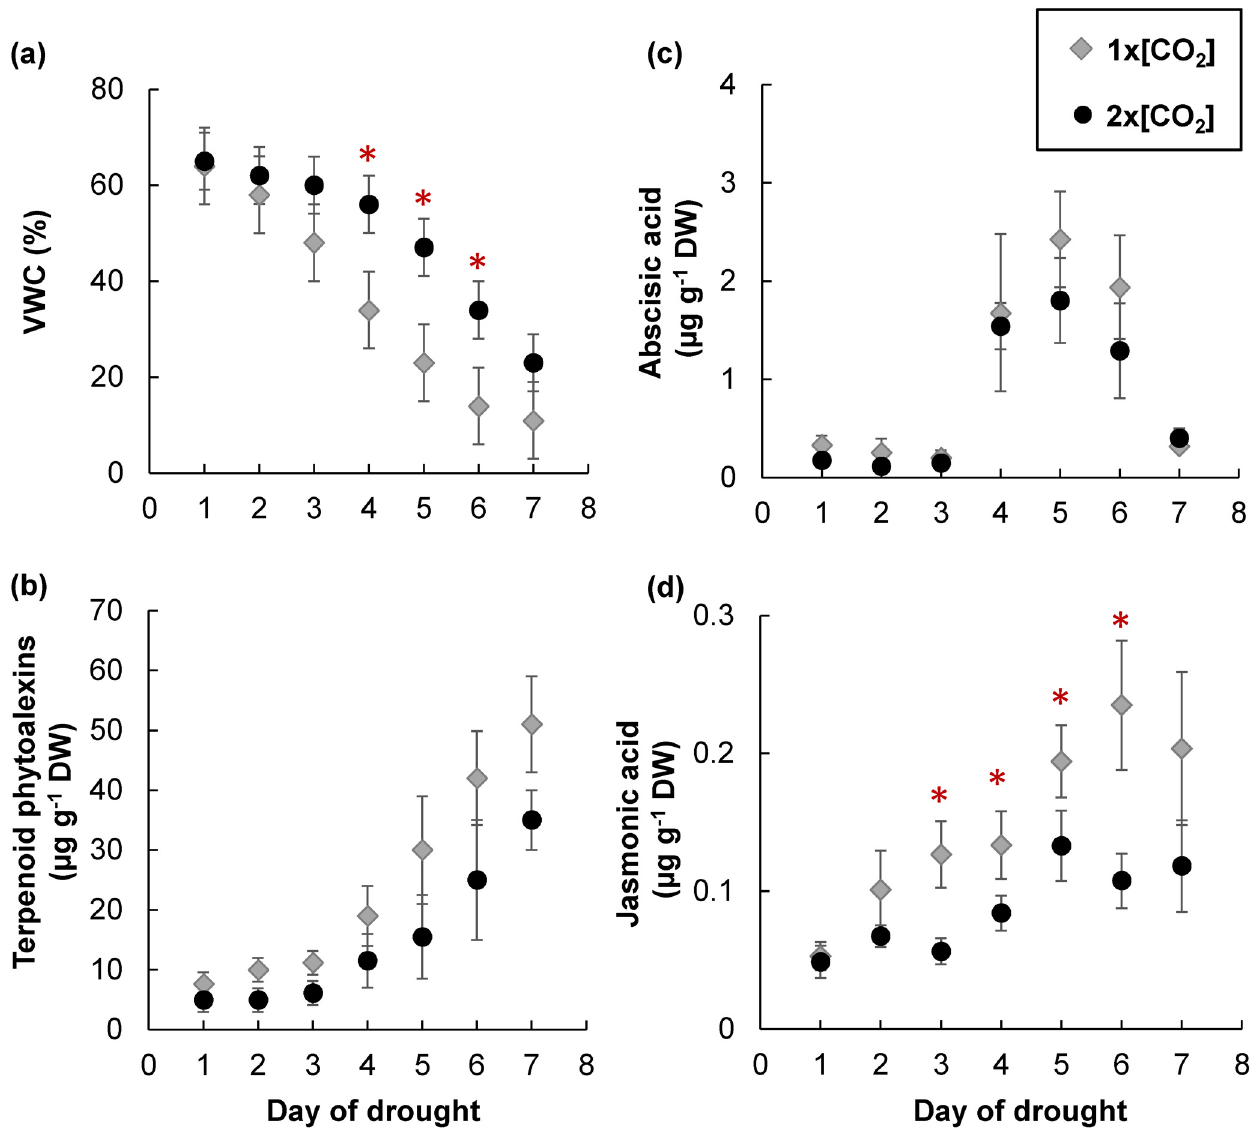
Fig 9. Elevated [CO 2 ] does not inhibit the drought induced accumulation of maize root terpenoid phytoalexins. Water was withheld from V8 stage plants at 1x[CO 2 ] and 2x[CO 2 ] for seven consecutive days throughout which the (a) percent volumetric water content (VWC) was monitored using an EC-5 soil moisture sensor. Each day a subset of roots was collected for extraction and quantification of (b) total terpenoid phytoalexins (sum of both the zealexin and kauralexin metabolites), (c) abscisic acid, (d) jasmonic acid. Values represent the mean ( ± SEM) of five samples at each corresponding day of drought. The variable mean at 1x[CO 2 ] and 2x[CO 2 ] for each time point was compared independent of others using a Student ’ s t -test. Red asterisk indicate points at which values at 1x[CO 2 ] and 2x[CO 2 ] are significantly different ( P <